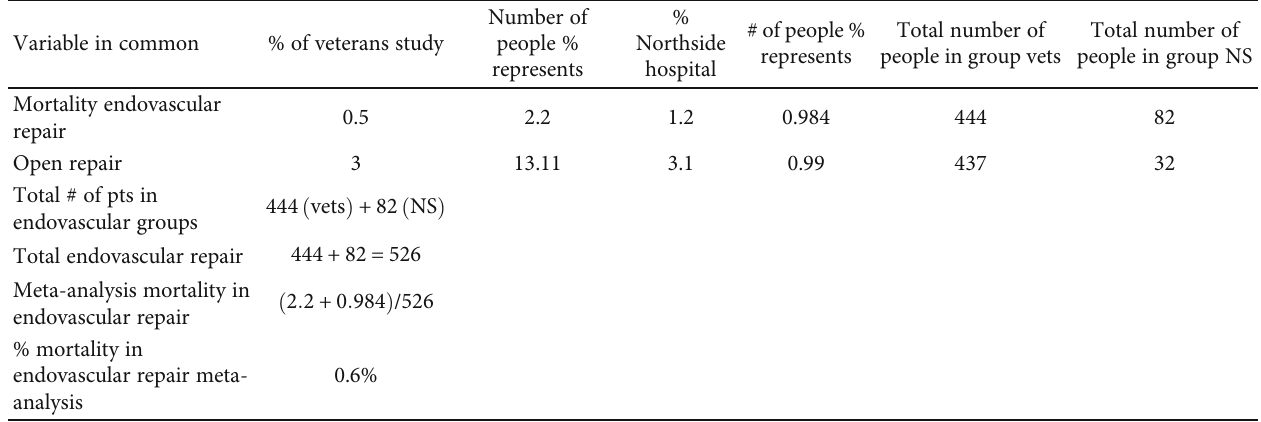
Table 3: Analysis of mortality with EVAR vs Open-Cutdown method: Northside Hospital Study with Open Versus Endovascular Repair (OVER) Veterans A ff airs Cooperative Study